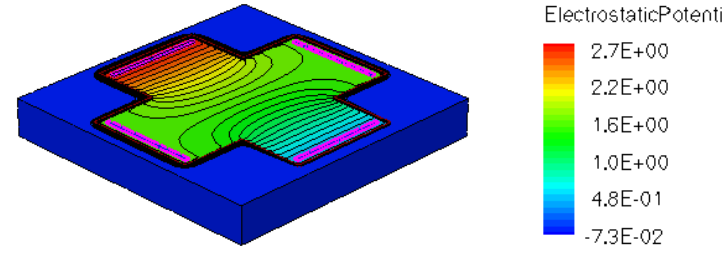
Figure 9. Electrostatic potential (V) for L structure, B = 0.5 T.